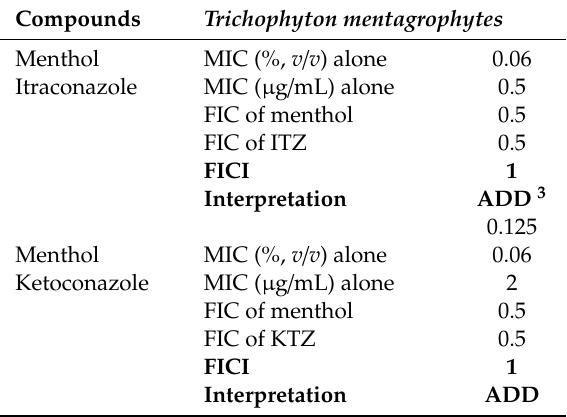
Figure 3. Isobolograms of synergistic interactions: plots of “Mentha of Pancalieri” EO and ITZ or KTZ against Trichophyton mentagrophytes . ITZ / KTZ FIC data are drafted on the x-axis, while EO FIC values are drafted on the y-axis: ( a ) isobologram plot of EO and ITZ against T. mentagrophytes ; ( b ) isobologram plot of EO and KTZ against T. mentagrophytes. Table 7. MIC 1 and FICI 2 of menthol and menthone plus itraconazole or ketoconazole against Trichophyton mentagrophytes.